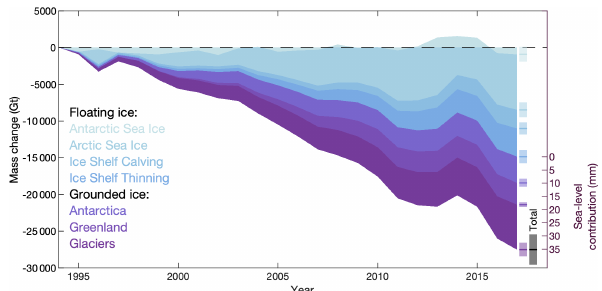
Figure 4. Global ice mass change between 1994 and 2017 par- titioned into the different floating (blues) and grounded (purples) components. Shaded bars indicate the cumulative mass change and estimated uncertainty for each individual ice component (blues, pur- ples) and their sum (black). The equivalent sea level contribution due to the loss of grounded ice from Antarctica, Greenland and mountain glaciers is shown in the y axis on the right-hand